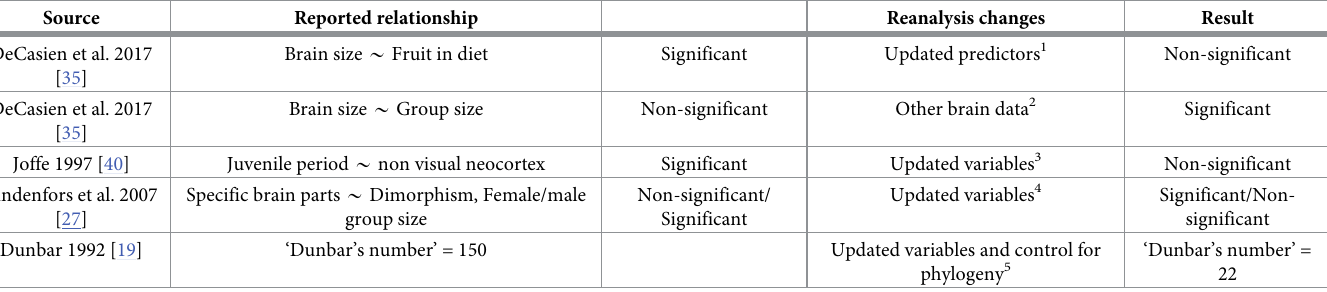
Table 7. Overview of changes in the relation between brain size and predictors as different data is used. N is identical to the original studies in all